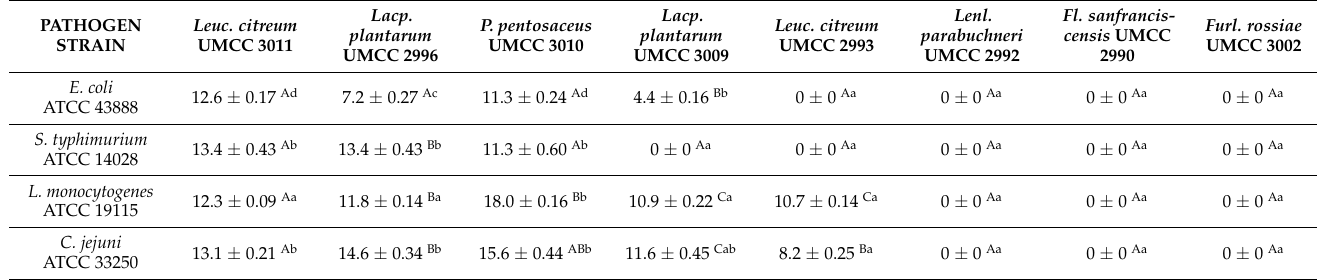
Table 3. Antimicrobial activity showed by some of the lactic acid bacteria strains tested in this study. Leuc. citreum PATHOGEN STRAIN UMCC